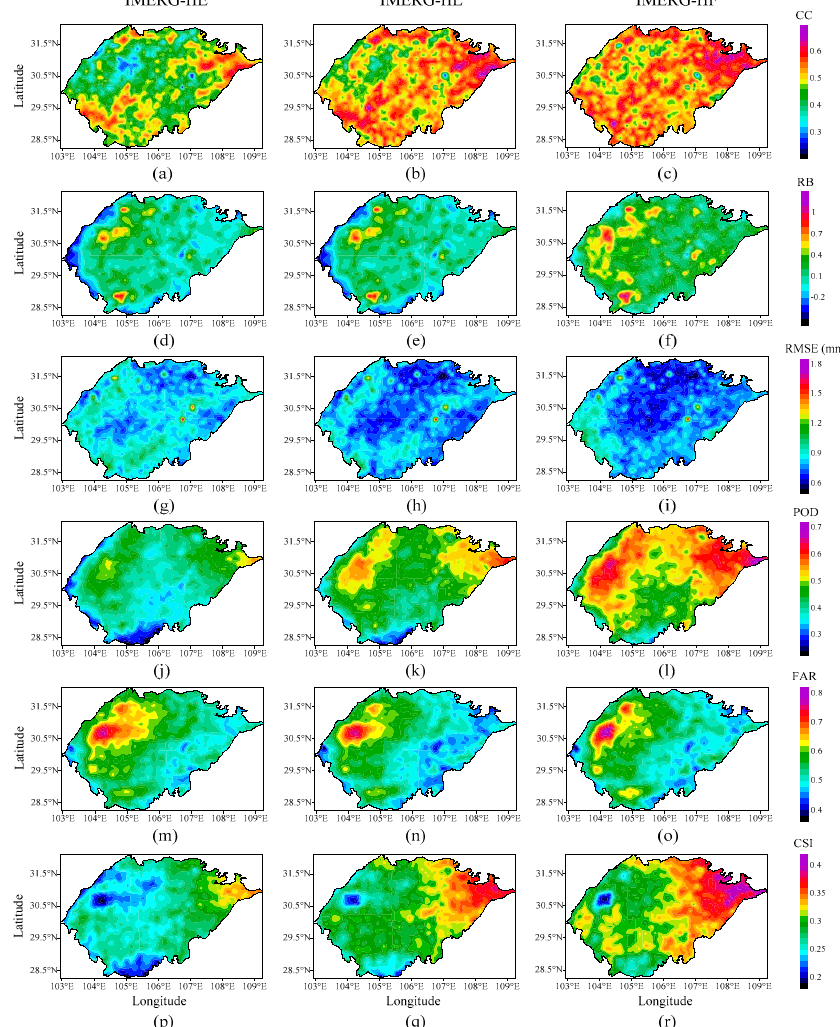
Figure 2. Spatial distributions of the statistical metrics for the IMERG-HE, IMERG-HL, and IMERG-HF products at grid scale over Sichuan Basin: ( a – c ) CC, ( d – f ) RB, ( g – i ) RMSE, ( j – l ) POD, ( m – o ) FAR, ( p – r ) CSI.